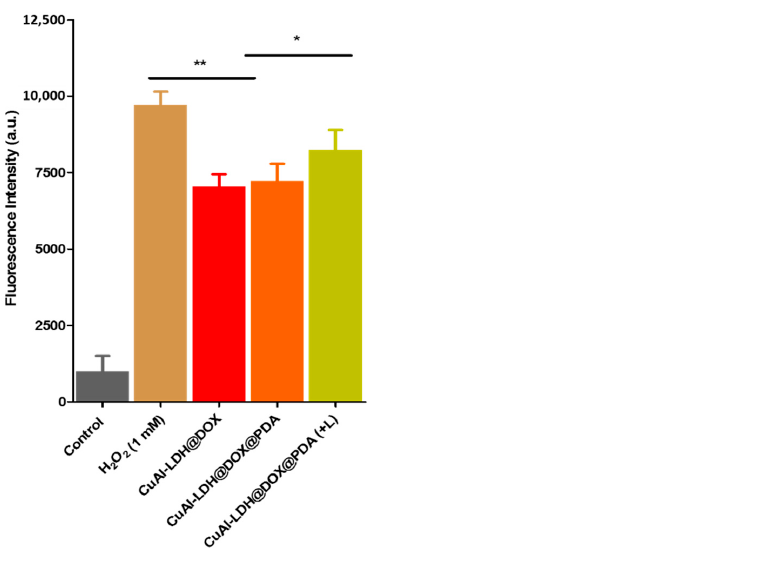
Figure 6. Intracellular ROS production in A549 cells treated with NCs with and without light